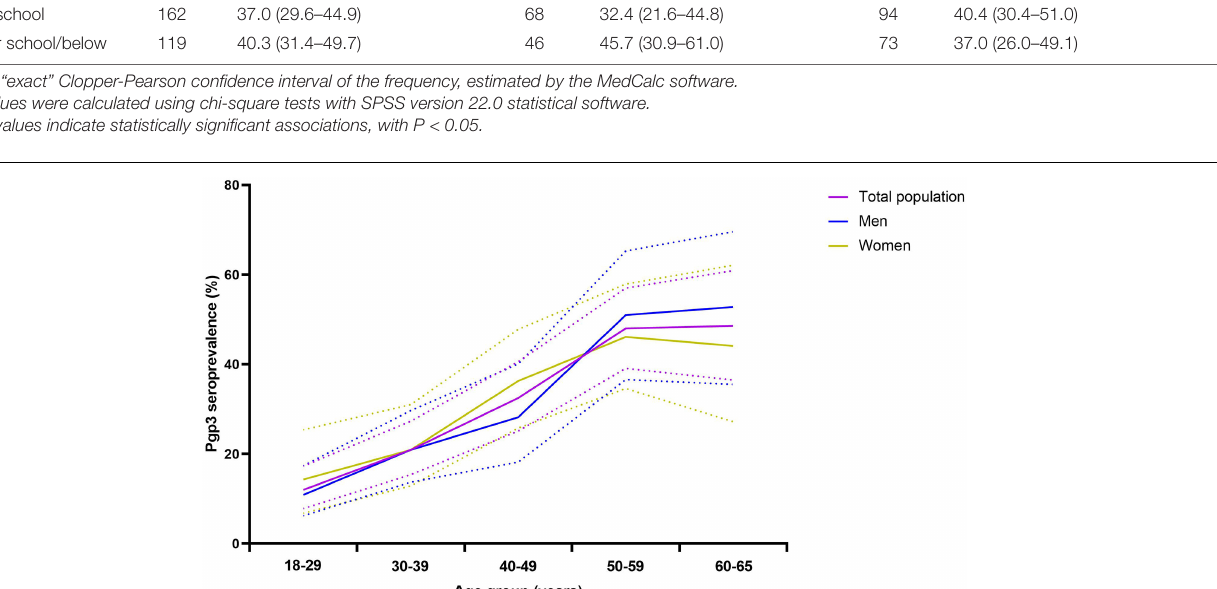
gradually increased up to 48.6% in the group of 60–65 years old. ( Figure 3 ) although the CT seropositive frequency was slightly higher in women than in men (31.3% vs. 25.4%) but